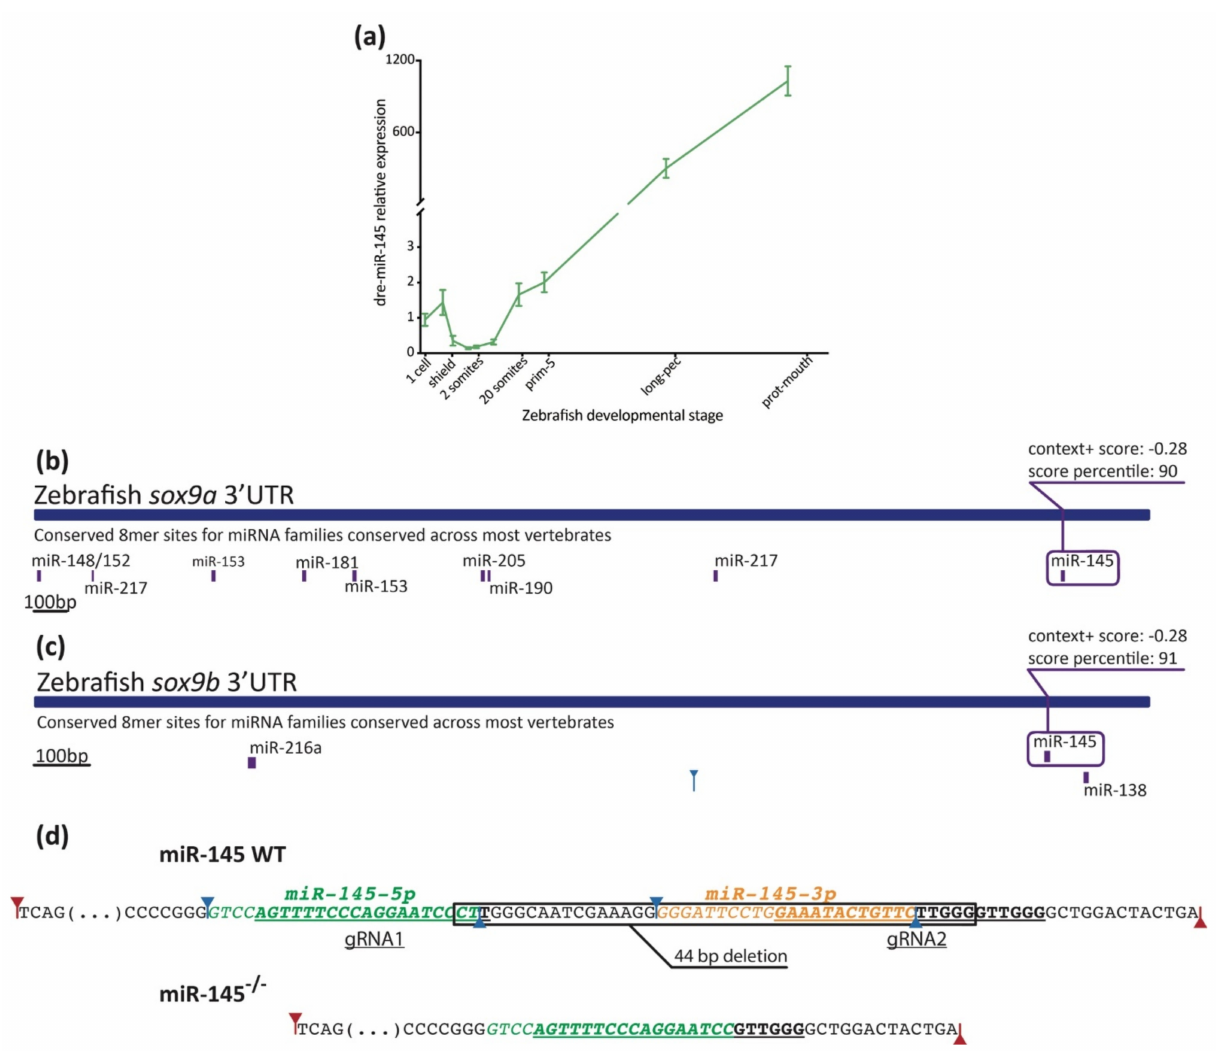
Figure 3. Measurement of miR-145 expression with stem–loop RT-qPCR. ( a ) MiR-145 temporal expression levels during zebrafish development ( ± SEM, n = 3). ( b , c ) Schematic representation of sox9a (ENSDARG00000003293) and sox9b (ENS- DARG00000043293) 3 (cid:48) UTR. Putative miRNA binding sites are shown below each region. MiR-145 sites are enclosed in purple boxes, with their respective context+ scores. ( d ) Schematic representation of miR-145 genomic wild-type sequence ( top ) and CRISPR/Cas9 mutant sequence ( bottom ). Mature mir-145-5p and -3p in green and orange, respectively, and underlined gRNA sequences are shown. Drosha and Dicer1 cleavage sites marked with red and blue arrows,